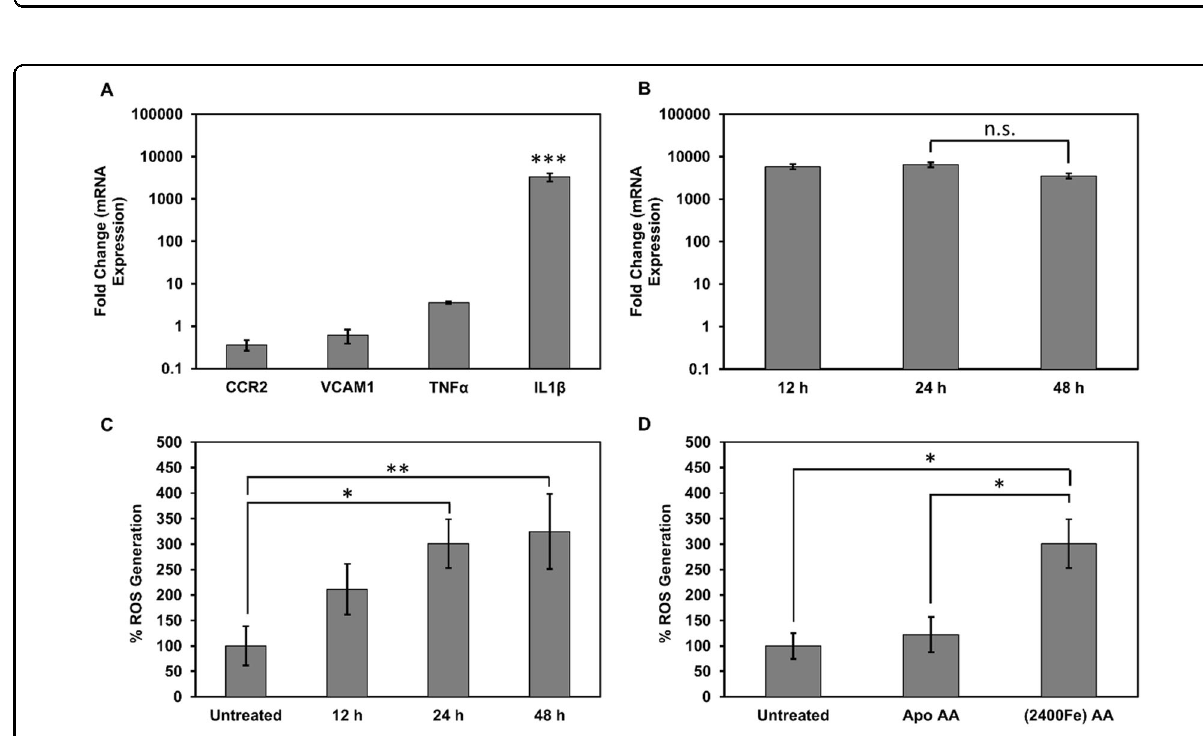
Fig. 6 Immunogenic responses of RAW264.7 to AfFtnAA treatment. A mRNA expression levels of cytokines and chemokines (CCR2, VCAM-1, TNF α and IL1 β ) in RAW264.7 cells treated with AfFtnAA for 48 h. B Time-dependent IL1 β mRNA expression level changes in cells treated with 200 nM AfFtnAA (12, 24, 48 h). The expression levels of the target genes were normalized to those of untreated cells to determine the fold change. C Measurements of ROS generation in cells treated with AfFtnAA for different lengths of time (12, 24, 48 h). D Measurements of ROS generation in cells treated with ApoAA and iron-loaded AfFtnAA for 24 h. The ROS generated (measured as mean fl uorescence intensity) is expressed as a percentage with respect to the mean fl uorescence of the untreated cells ( n = 3) (* p < 0.05, ** p < 0.01, *** p <